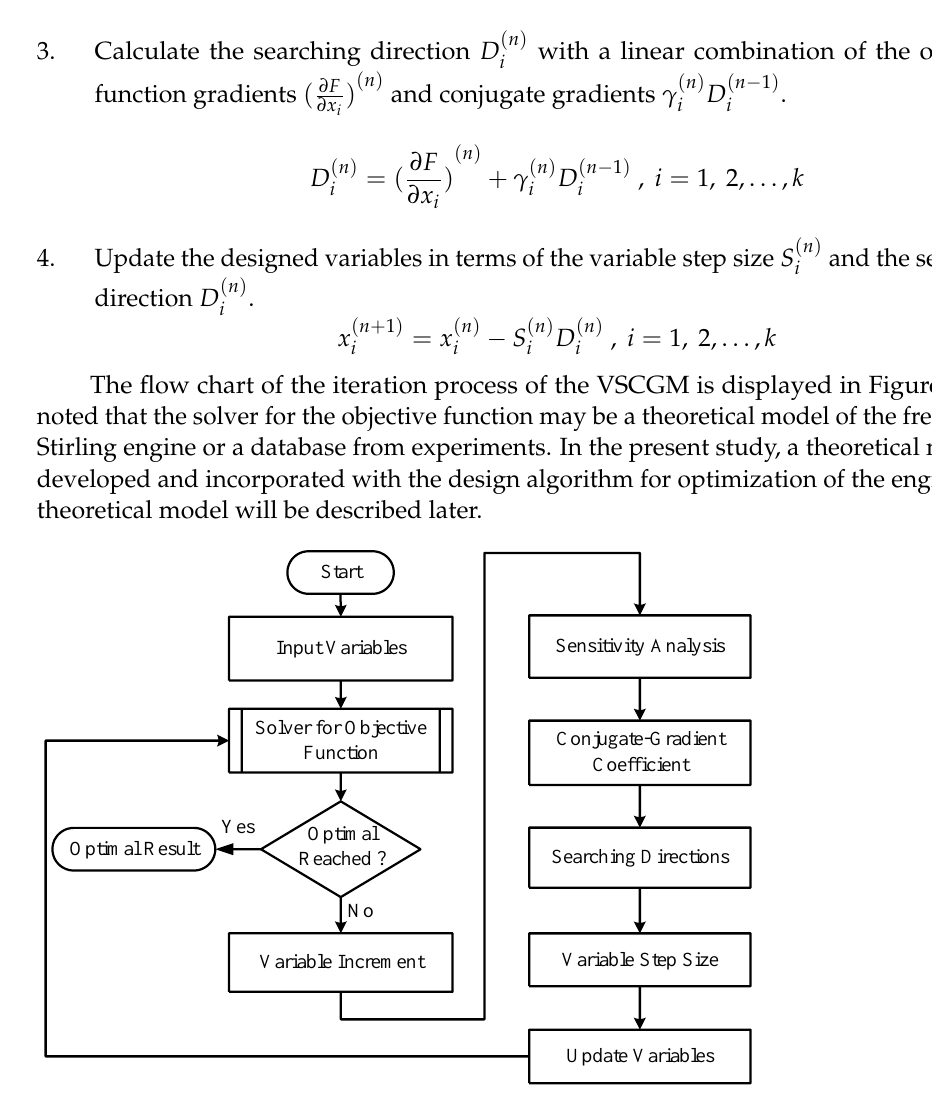
Figure 4. Flow chart of the variable-step size simplified conjugate gradient method.